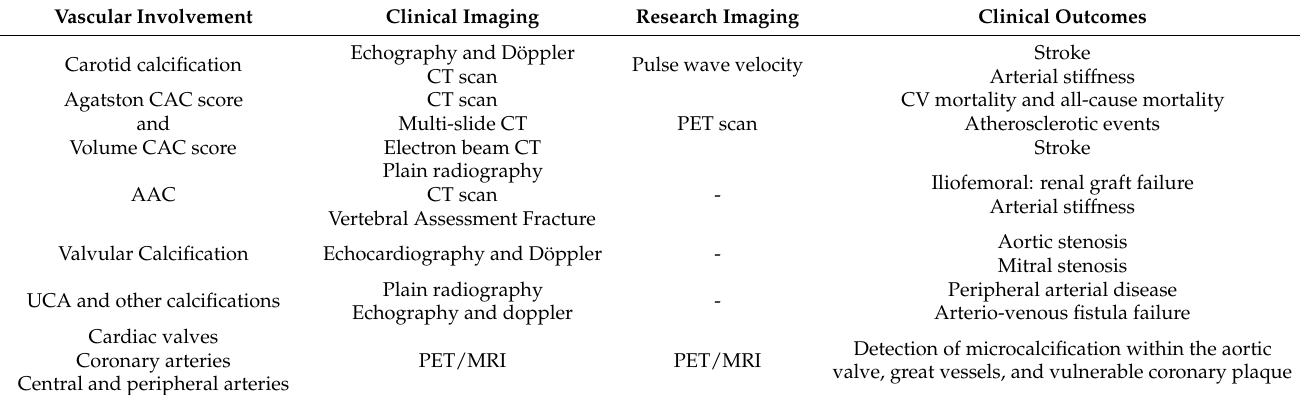
Table 2. Major imaging techniques for the exploration of cardiovascular